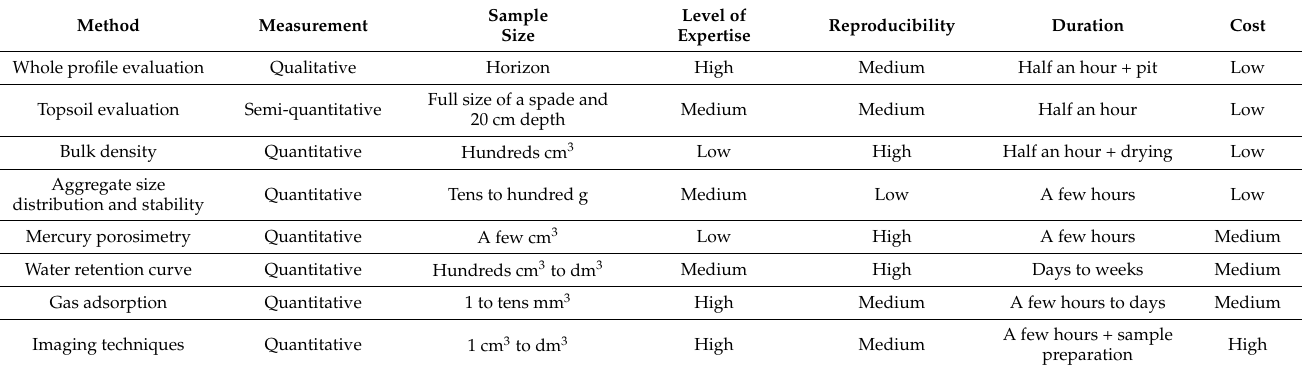
Table 1. Summary of the methods to assess soil structural characteristics. Modified from Rabot et al. [68].